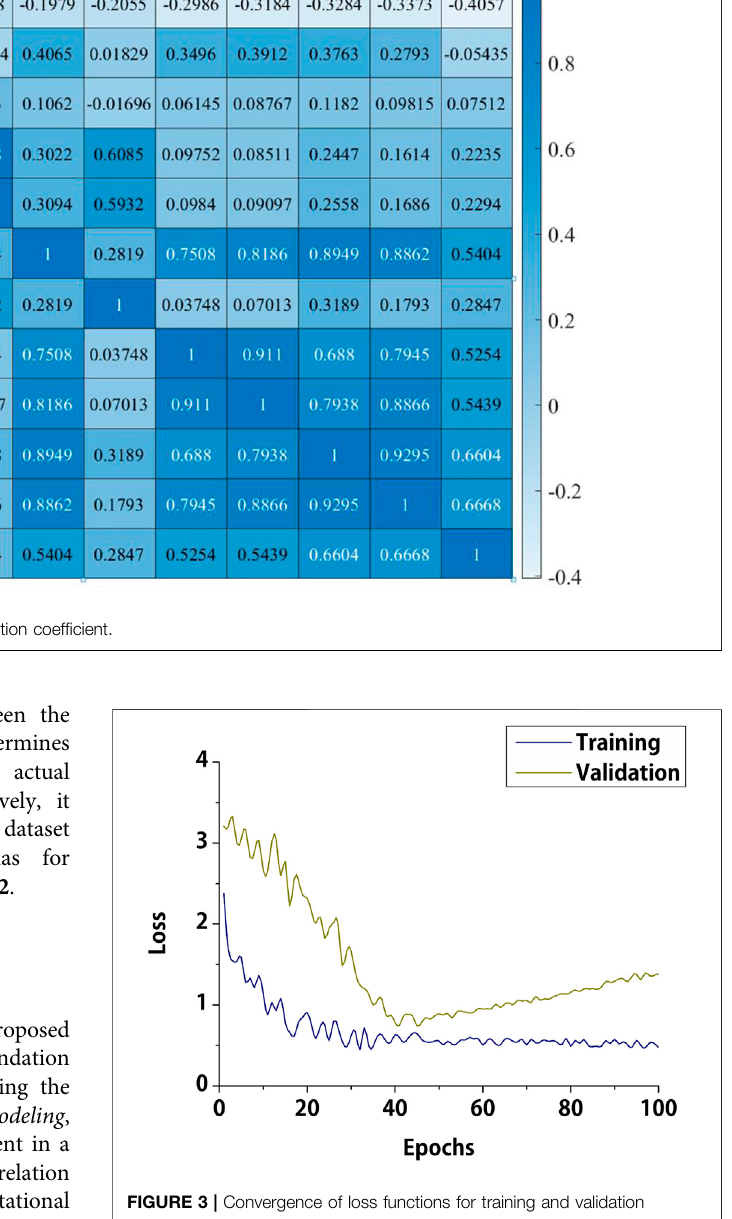
FIGURE 3 | Convergence of loss functions for training and validation